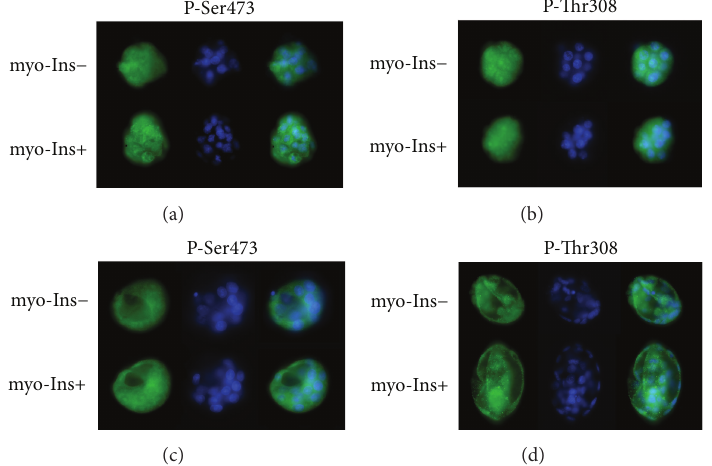
Figure 3: Localization of phosphorylated Akt in preimplantation embryos at the morula and blastocyst stage, after continuous culture in the presence or absence of myo-Ins. ((a), (b)) morula stage embryos; ((c), (d)) blastocyst stage embryos. In each panel, from left to right: FITC, Hoechst 33343, merge. The same pattern was consistently observed in all embryos analyzed; panels show representative embryos. Statistical analysis on these embryos, reported in the text, was performed on at least three embryos at the morula and blastocyst stages in three independent experiments.